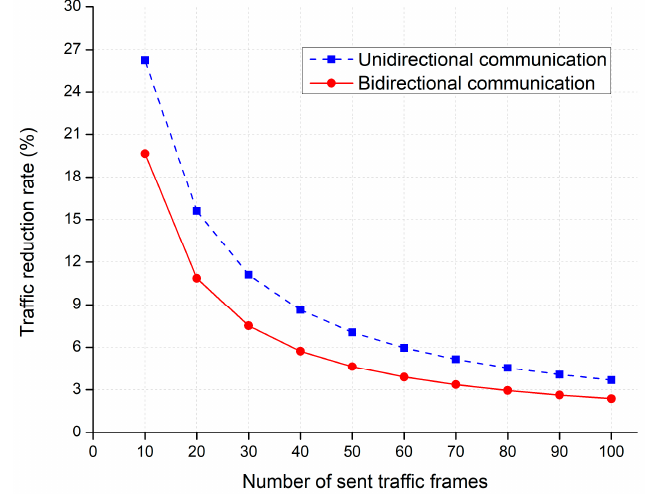
Figure 12. Traffic reduction (%) of eEFA compared to EFA for both bidirectional and unidirectional communications.